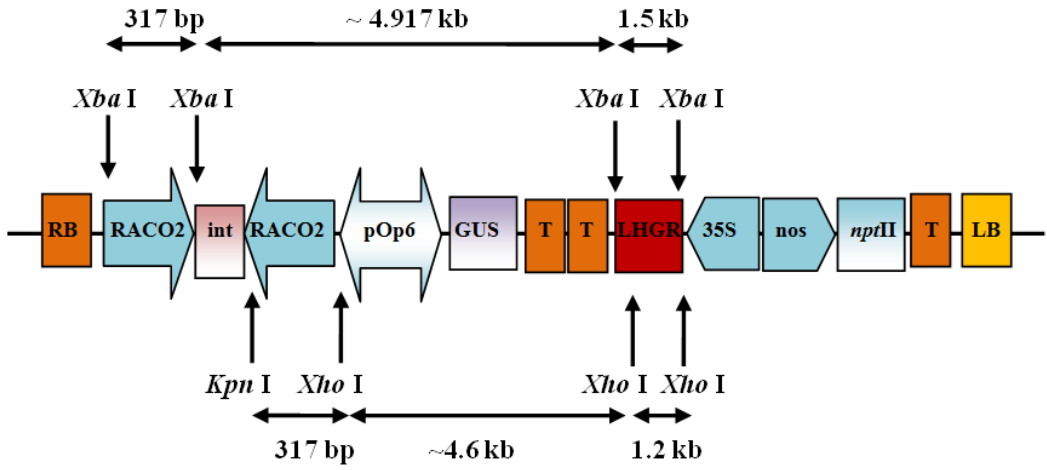
Figure 4. Construct map of pRNAiACO2 (RACO2) construct with ACO2 gene. The sequence base pair length for pRNAiACO2 (317bp) construct is as indicated. RB: T-DNA right border, LB: T-DNA left border, int: pyruvate orthophosphate dikinase intron, pOp6: pOp6 promoter, 35S: cauliflower mosaic virus 35S RNA promoter, npt II: kanamycin resistance gene, GUS : β -glucoronidase gene, nos: nopaline synthase promoter, T: terminator. Letters on the top and bottom rows indicate the restriction enzyme sites for Xba I, Kpn I and Xho